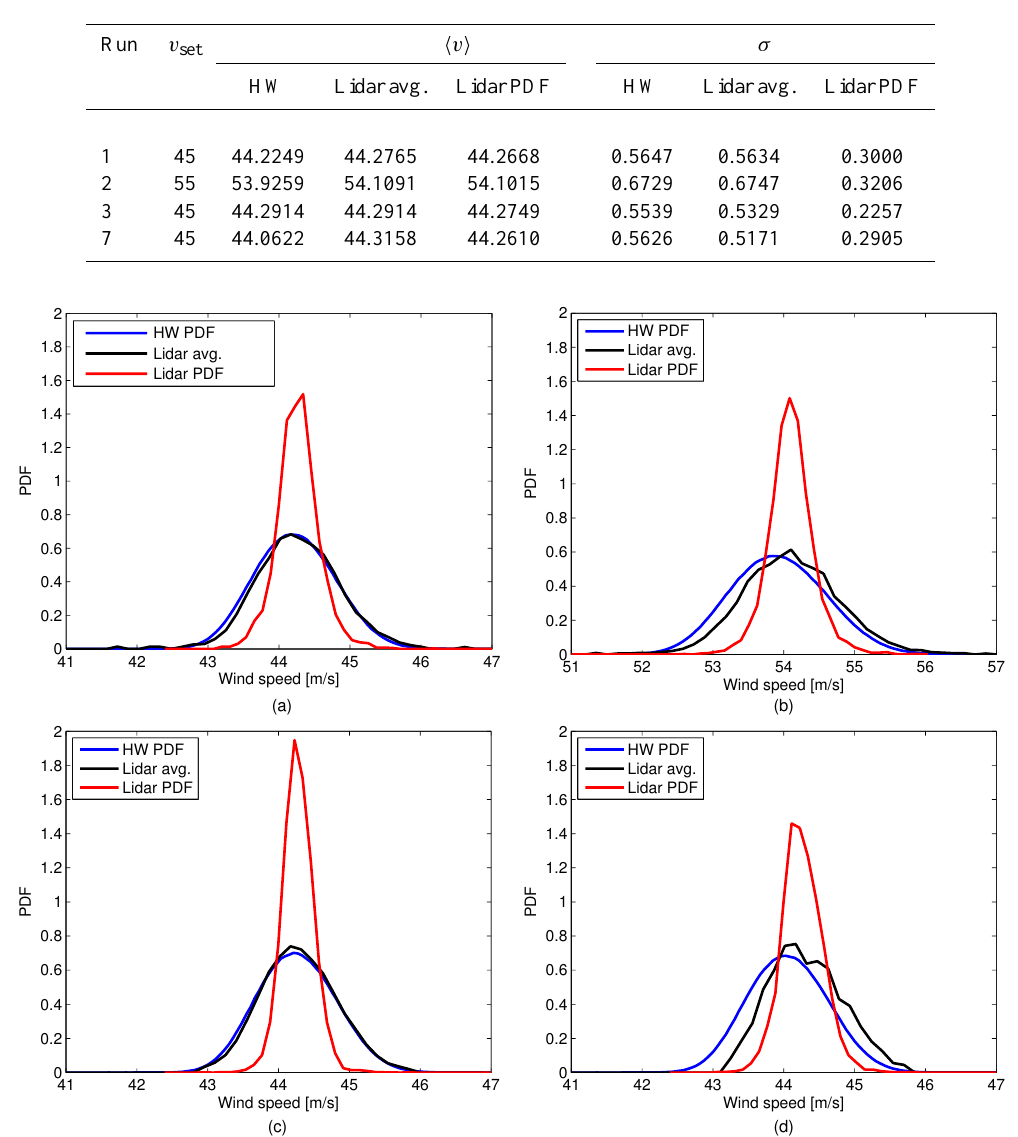
Table 1. Mean wind speeds and widths for the different instruments and analysis methods. Dimensional variables are in metres per second.